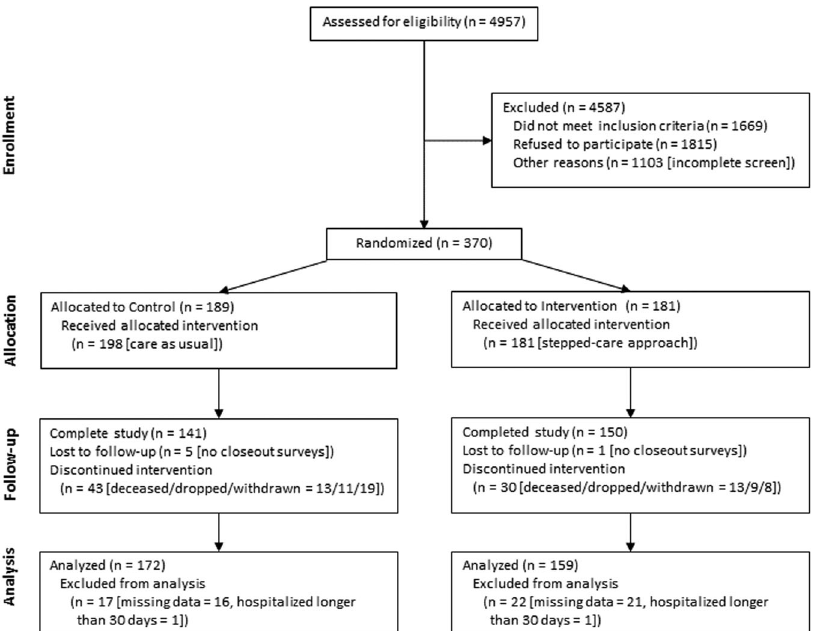
Fig. 1 Participant fl owchart. Figure 1 summarizes the recruitment, randomization, and retention fl ow of patients in this study, leading to the fi nal analyzed